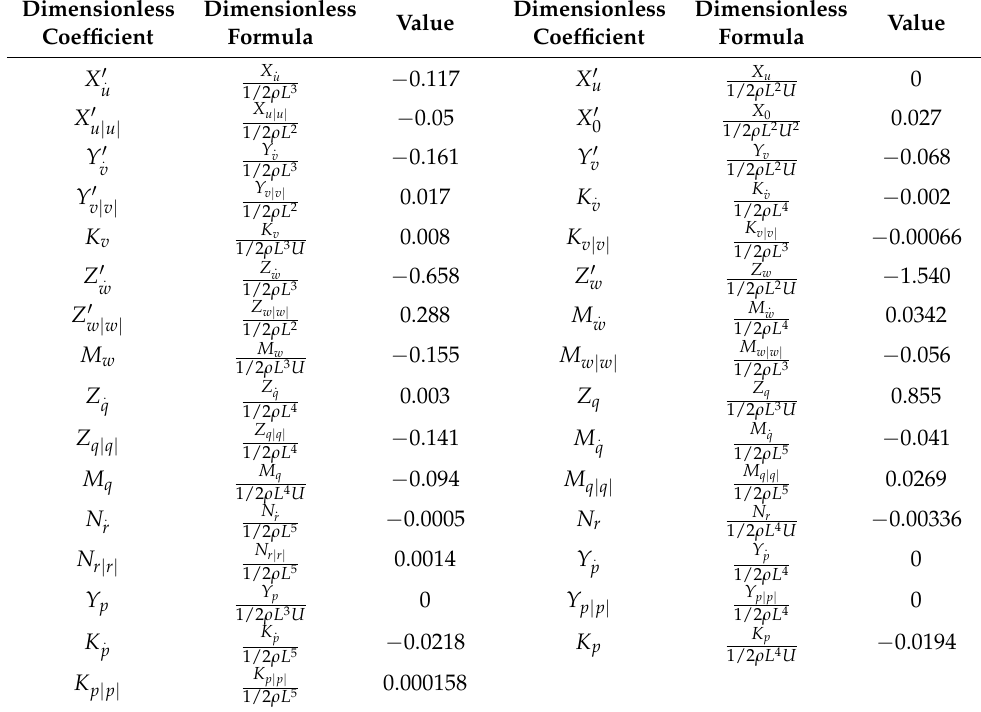
Table 3. Dimensionless hydrodynamic coefficient of